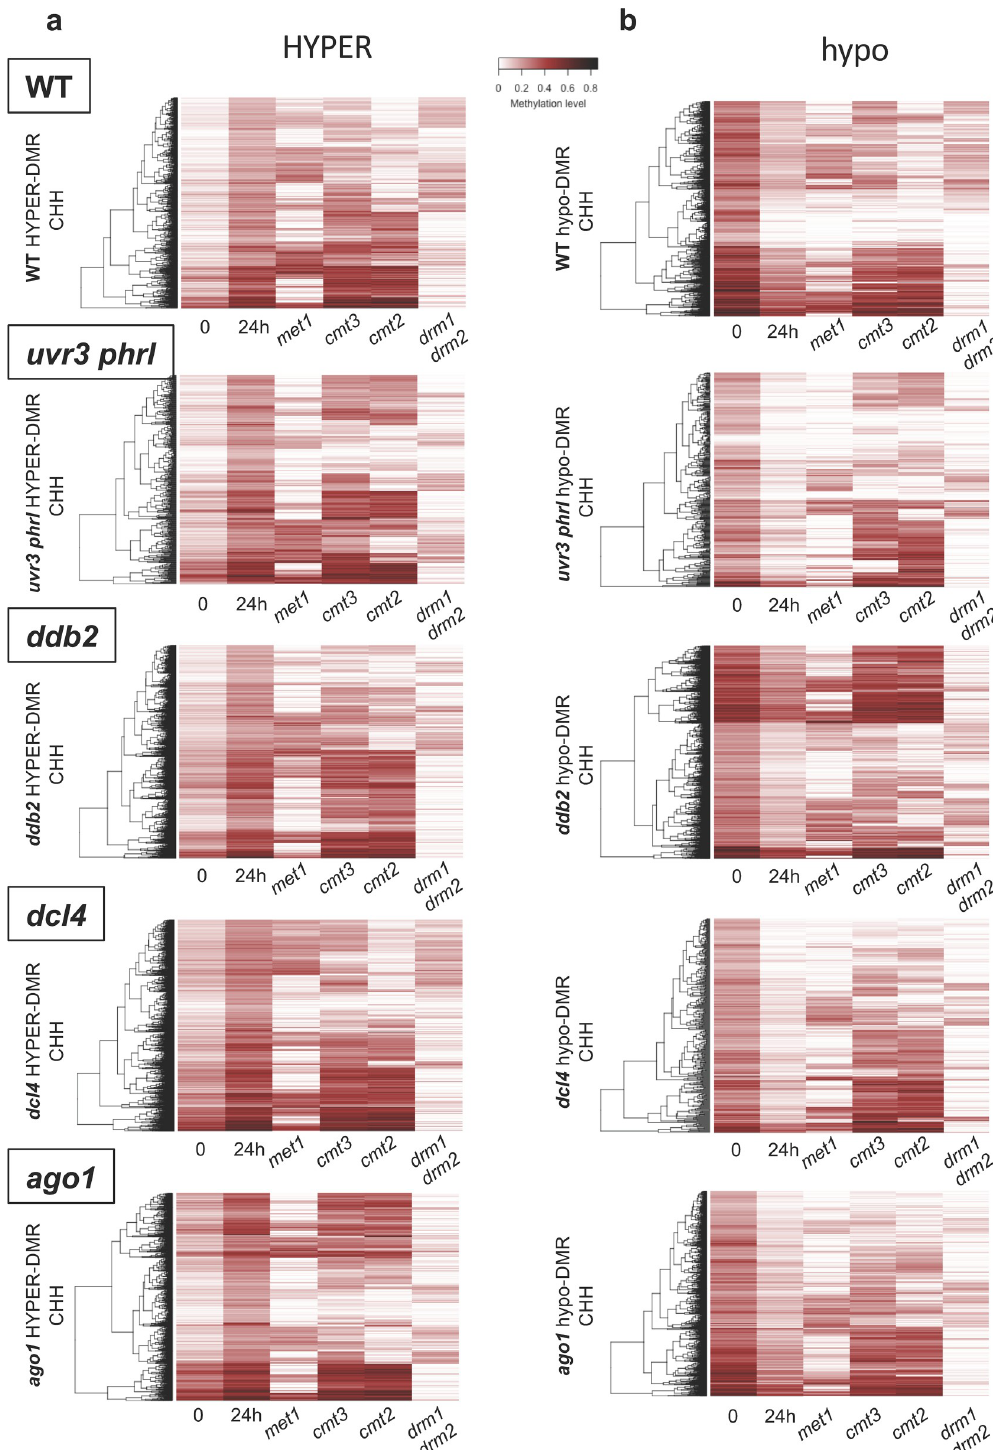
Fig 3. UV-induced DMRs and DNA methyltransferases. Heatmaps of CHH methylation levels within hyper-DMRs (a) and hypo-DMRs ( b) identified in WT, uvr3 phrI , ddb2 , dcl4 and ago1 plants 24h upon UV-C exposure. The CHH methylation levels of each of these hyper-DMR are reported for met1 , cmt2 , cmt3 and drm1/2 mutant plants. Columns represent data for each indicated genotype (white: 0; black: 1).